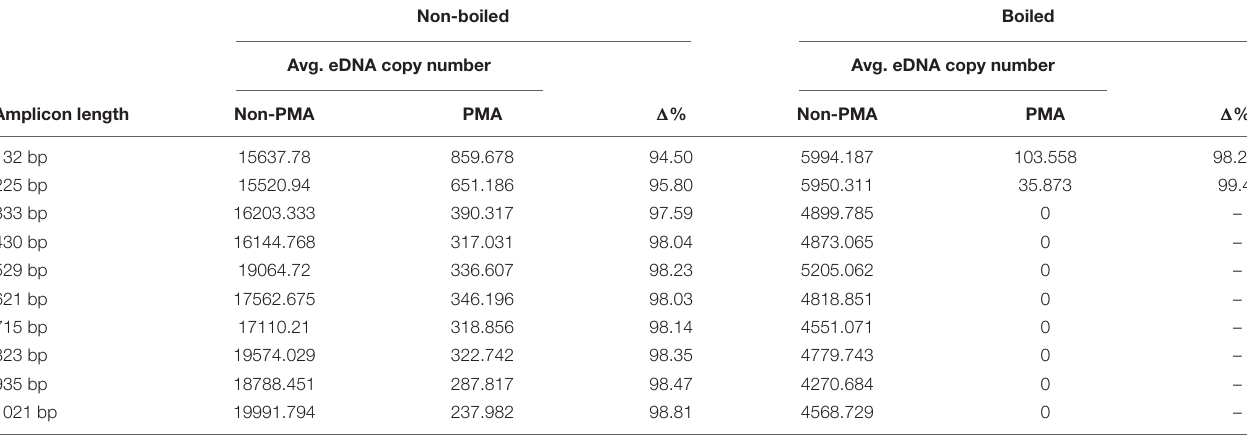
TABLE 2 | Percentage decrease of average eDNA copy number (shown as (cid:49) %) for each assay by PMA treatment in non-boiled and boiled treatments.